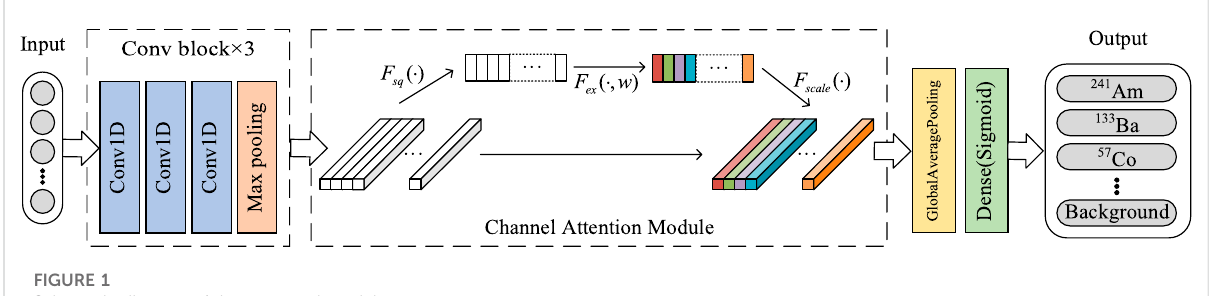
FIGURE 1 Schematic diagram of the proposed model.